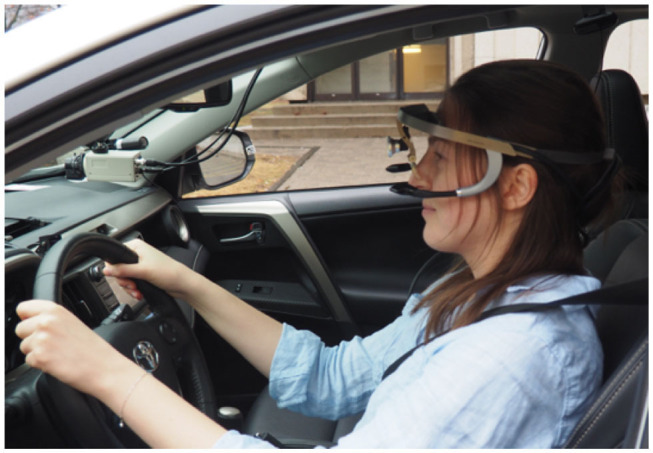
Driver outfitted with Dikablis eye-tracking glasses.